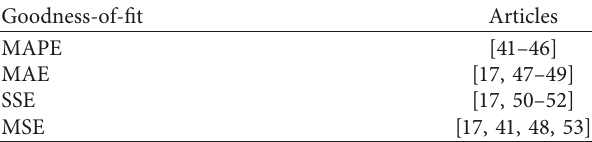
Table 6: Summary of goodness-of-fit